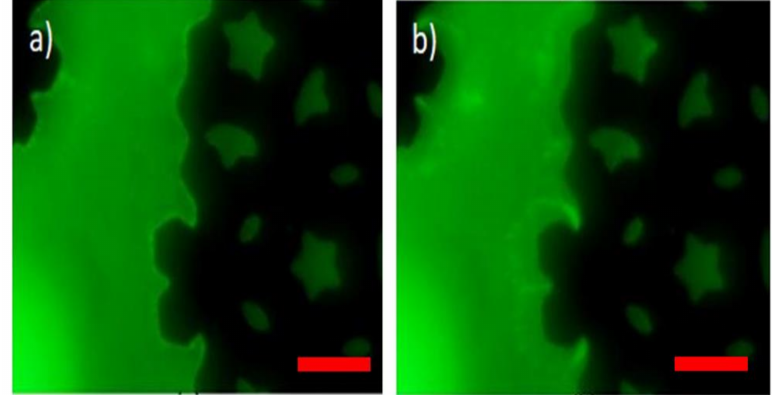
Figure 3. Demonstration of negative DEP effect through time-lapse images captured through the DEP spectroscopy application (Assuming t = 0 when electric field frequency is changed to induce negative DEP): ( a ) t = 0 ms and ( b ) t = 40 ms. The concentration of CA 19-9 in this solution is 37 U/mL. The interdigitated electrode is visible as darker region in the picture. The bright layer visible on the edge of the electrode is formed by the accumulation of the sample. As the frequency is changed to induce negative DEP the antigen-bound PM are repelled from the electrode. For 60 s prior to the image ( a ), a 10 V peak-to-peak electric field at 10 kHz, which produces positive DEP, was applied to the electrodes. Then, the frequency of the electric field increased to 500 kHz, producing negative DEP. The scale bar on both the figures indicates 50 µ